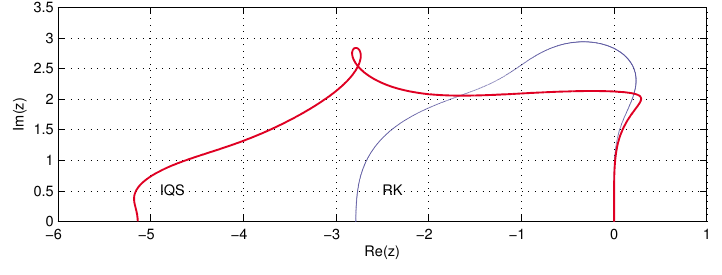
Figure 8. Stability regions of RK method of order p = 4 and GLMs with p = q = s = 4,